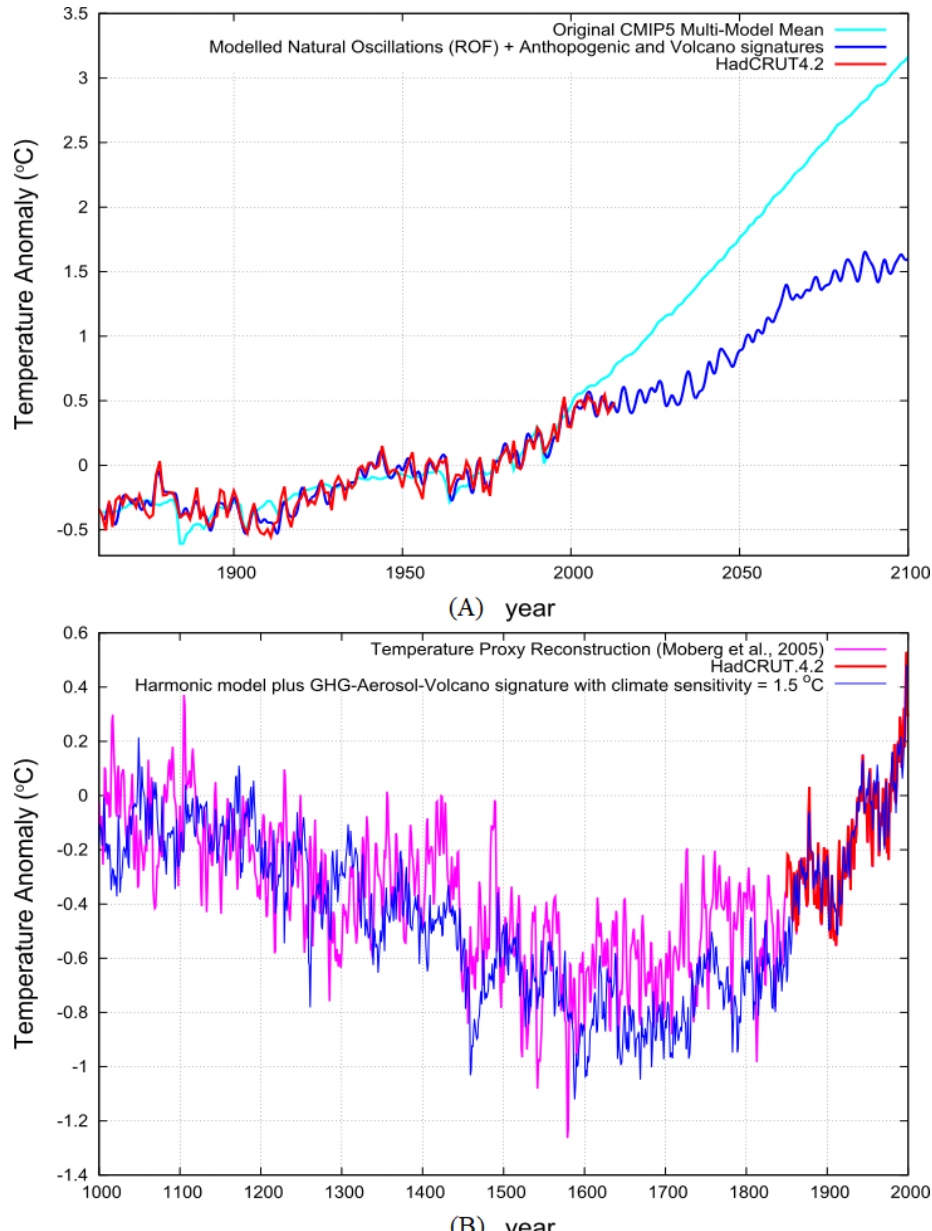
Figure 11. ( A ) HadCRUT4 global surface temperature record (red) versus the full semi-empirical cli- mate model (blue) made of the regression optimized oscillations plus the anthropogenic and volcano effects modeled by Equation (9) with the parameters reported in Table 2 using the regression opti- mized frequencies versus the original CMIP5 multi-model mean function. ( B ) The full semi-empirical climate model (blue) by Equation (11) using the same oscillations and the GHG+Aerosol+Volcano signature deduced by the energy balance model by Crowley [125] rescaled by a factor 3/4 to reduce the ECS from 2 ◦ C to 1.5 ◦ C for CO 2